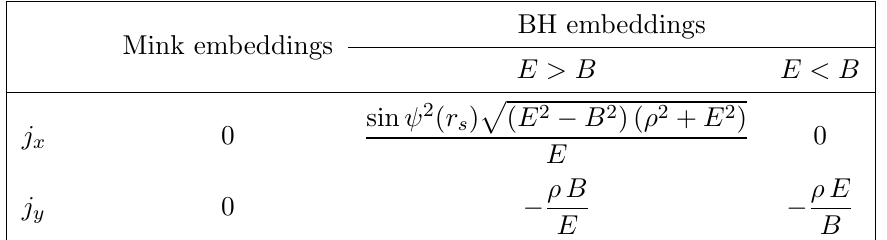
Table 2 . Currents for all the possible D5-brane con(cid:12)gurations.